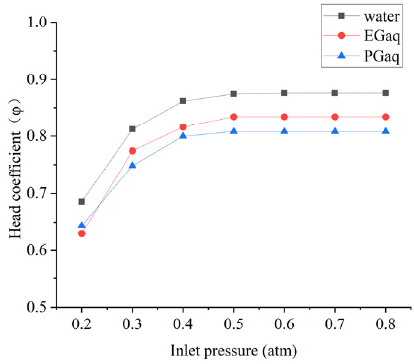
Figure 16. Cavitation curve of the pump with splitter blades at 20 °C.